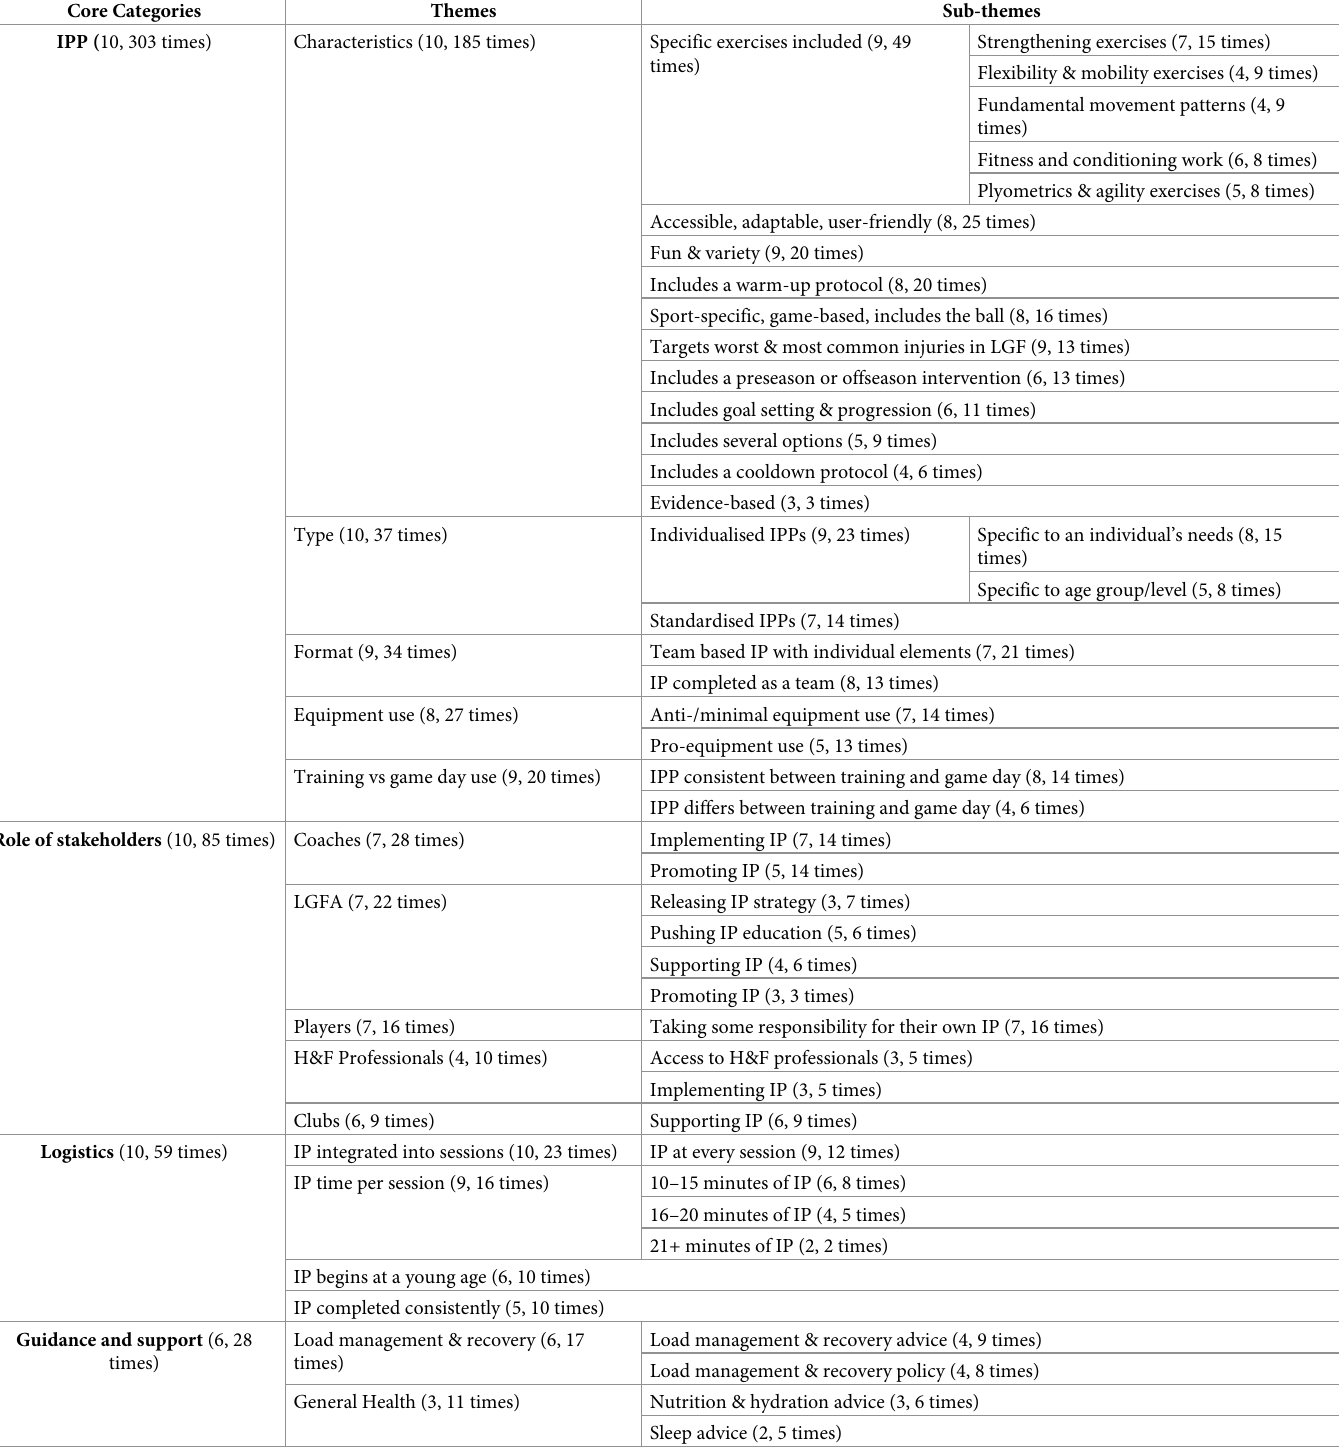
Table 2. Core categories, themes, and sub-themes surrounding players’ injury prevention strategy preferences (no. of players, no. of